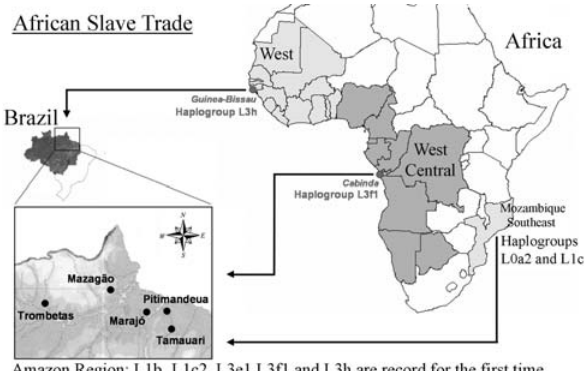
Figure 1 - Geographic localization of the Afro-descendant communities in the Brazilian Amazon region and the African probable origin of some mtDNA lineages observed in this